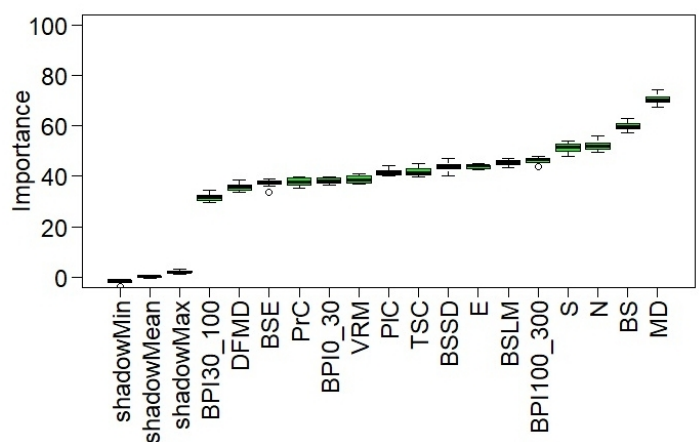
Figure 5. Boruta importance. See explanation in the text.